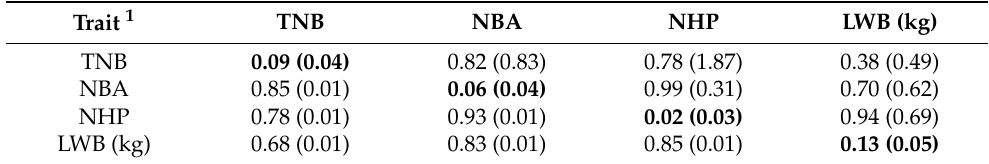
Table 2. Heritability (diagonal, bold), genetic correlation (above diagonal) and phenotypic correlation (below diagonal) for four litter